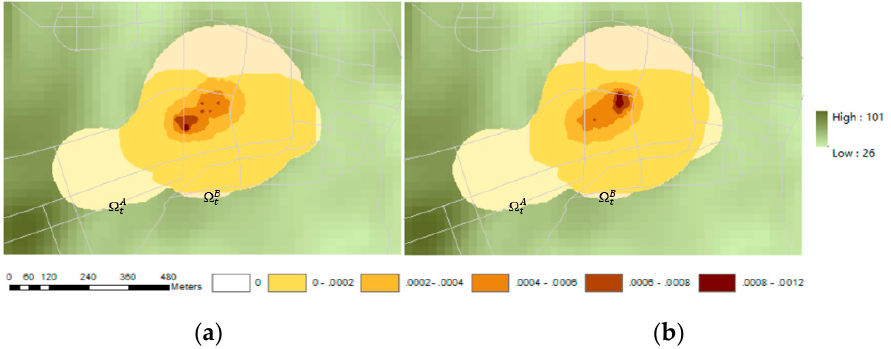
Figure 10. Probability map of A meeting B ( a ) and that of B meeting A ( b ) in obstacle